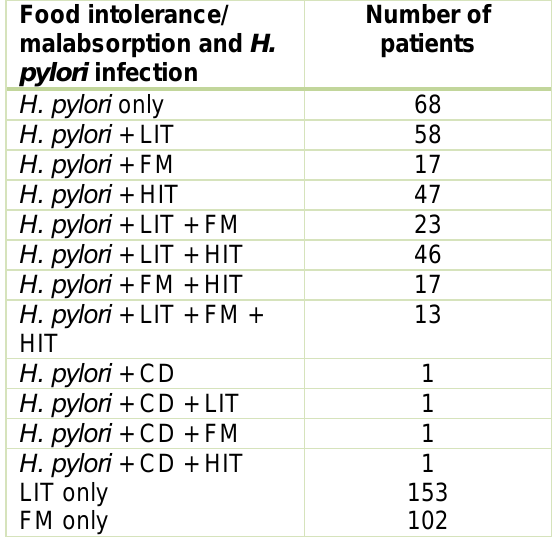
Table 1: Combinations of H. pylori infection and additional food intolerance/malabsorption found in 548 patients with IBS spectrum symptoms, 293 patients had H. pylori infection. Separate 153 LIT- only and 102 FM-only patients, without H. pylori, infection, were included in evaluations.